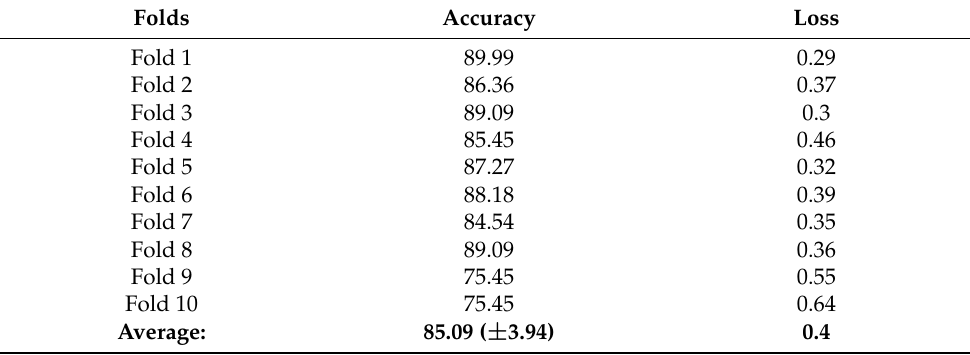
Table 8. Runs of 10-fold cross-validation for the proposed DenseNet-121. Folds